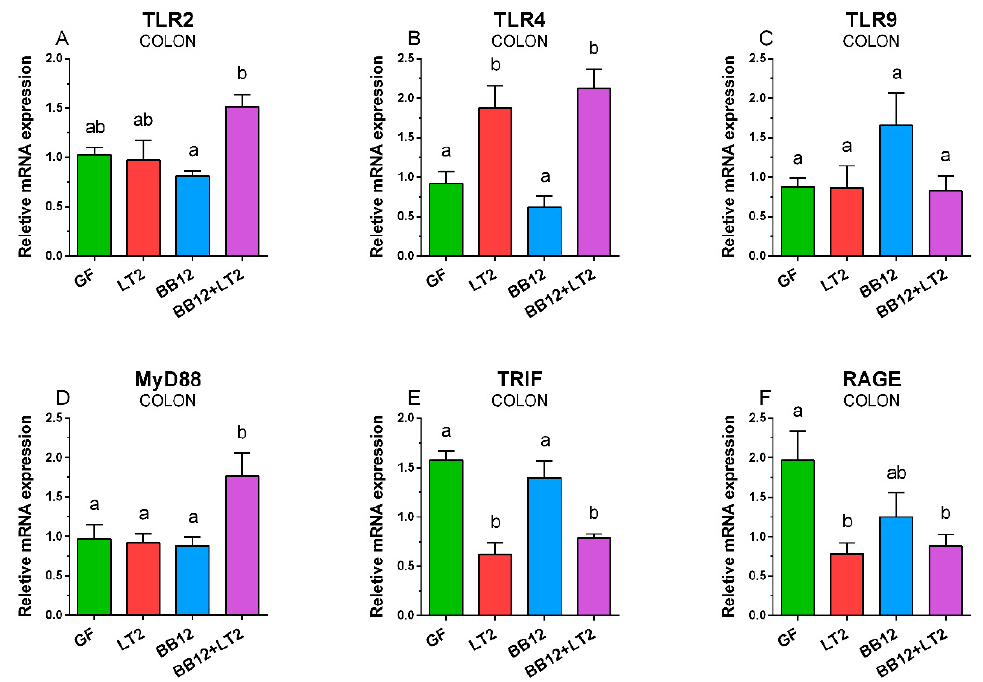
Figure 4. Relative expression (fold-change) of TLR2 ( A ), TLR4 ( B ), TLR9 ( C ), MyD88 ( D ), TRIF ( E ), and RAGE ( F ) mRNA in the colon of the one-week-old gnotobiotic piglets: germ-free (GF), infected with S . Typhimurium LT2 for 24 h (LT2), associated with B. animalis subsp. lactis BB-12 (BB12), and associated with BB12 and infected with LT2 for 24 h (BB12 + LT2). Six samples from each group were analyzed, and statistical differences were calculated by a two-way ANOVA with Tukey’s multiple comparison post hoc test. The values are presented as mean + SEM, and a p < 0.05 among groups is denoted by different letters above the columns.